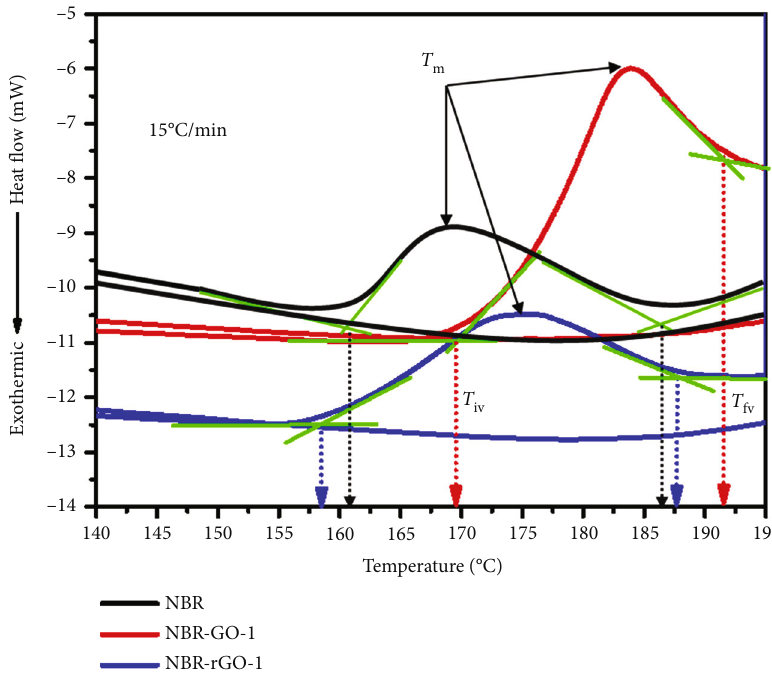
Figure 6: A typical DSC curve obtained for the non-activated sulfur cured vulcanizates at 15 ° C/minutes heating